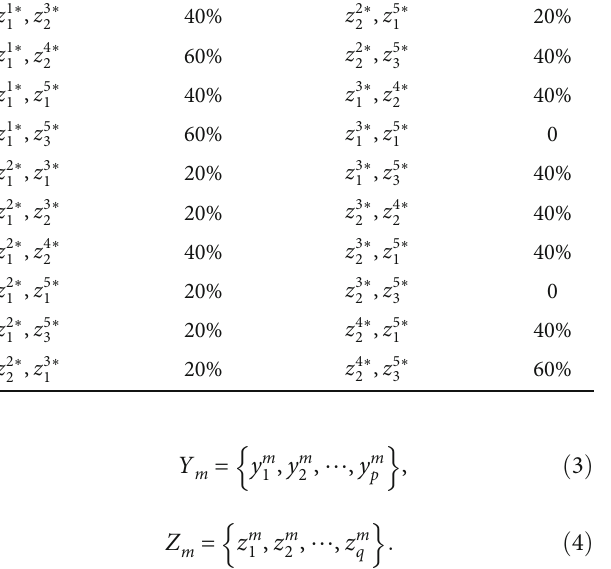
Table 6: Frequent item set L